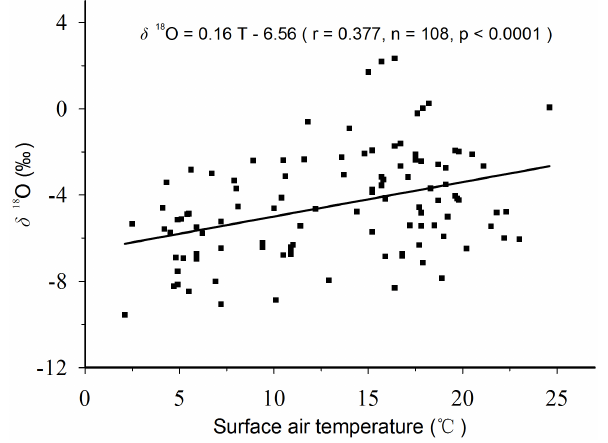
Figure 6. Correlation between daily precipitation δ 18 O and surface air temperature in the non-monsoon seasons of the observation pe- riod in Nanjing. Linear regression line, correlation coefficient r and p values are also